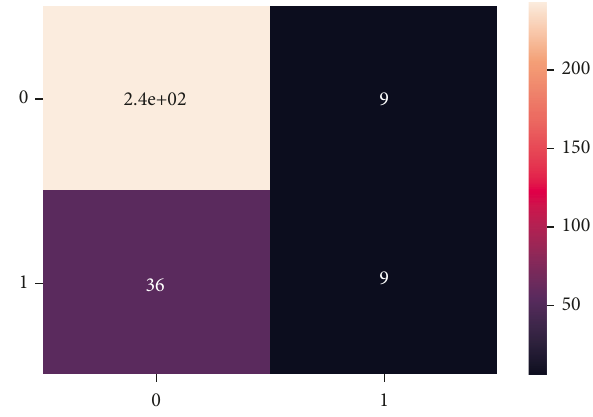
Figure 10: Confusion matrix of LR